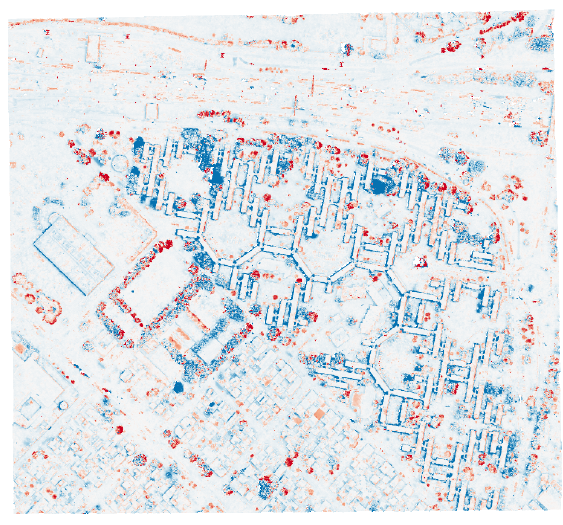
Figure 9. Difference between computed DSM and reference lidar image, ranging from -4 meters (blue) to 10 meters (red) Completeness Median (m) RMSE (m) Proposed 68.39 % Table 3. Performances comparison between our pipeline and metrics ranges from the IARPA challenge (Bosch et al.,